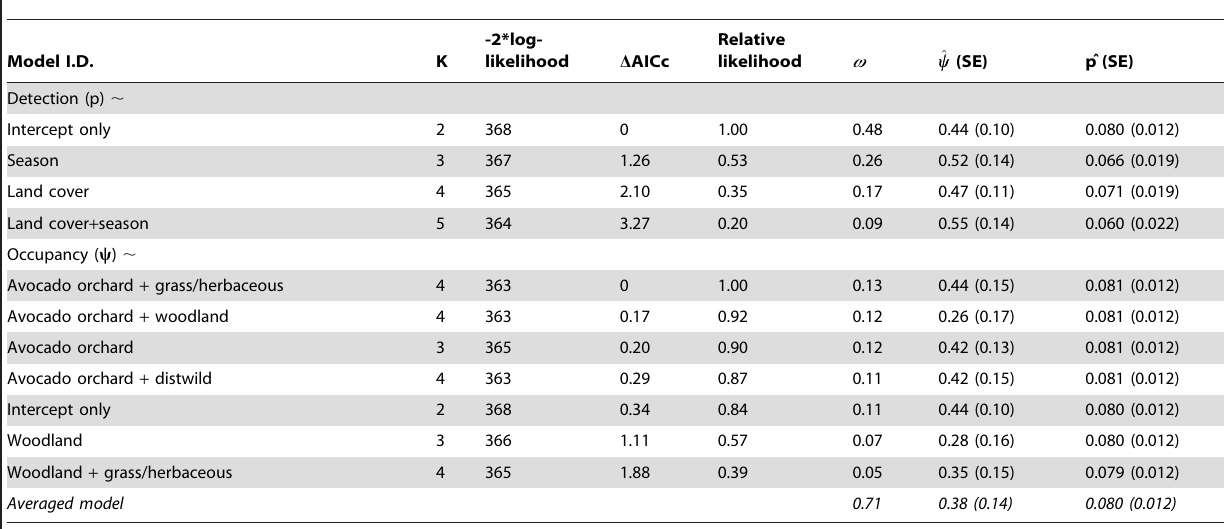
Table 3. Top-ranked models of site occupancy ( y ) and detection rate (p) for bobcat.